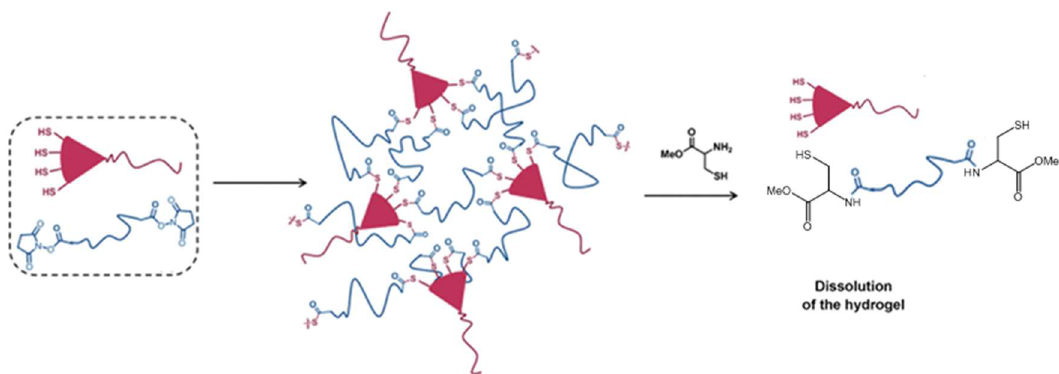
Figure 12. The use of NCL to dissolve a thioester-linked hydrogel network by the addition of a cysteine derivative. Image modified with permission from [57]. Copyright 2013 Wiley.